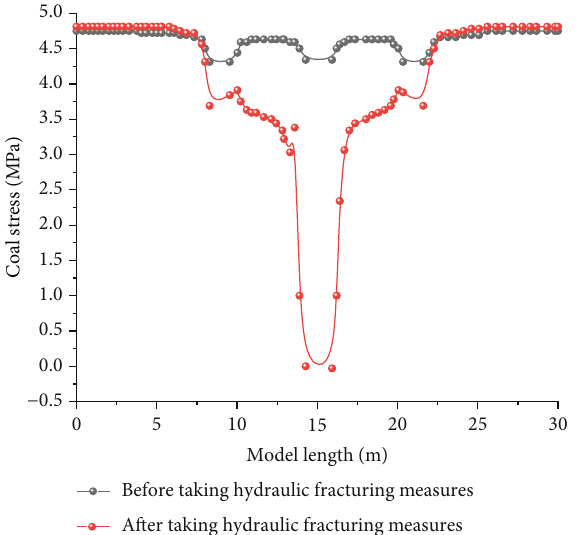
Figure 11: Curve of coal permeability changes before and after implementing hydraulic fracturing